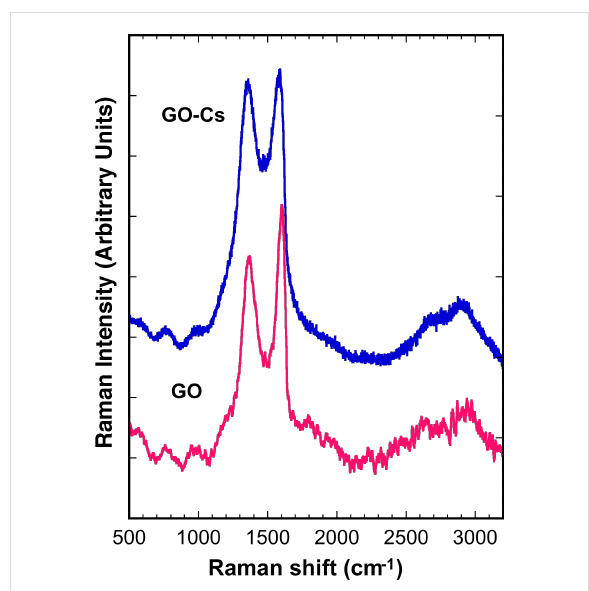
Figure 4: Raman spectra of GO-Cs and GO, displaying intense D and G peaks at ≈ 1380 and ≈ 1600 cm − 1 , respectively. The increase of the D peak, which is the signature of defects in graphene and GO, is clearly linked to the presence of Cs in GO-Cs.